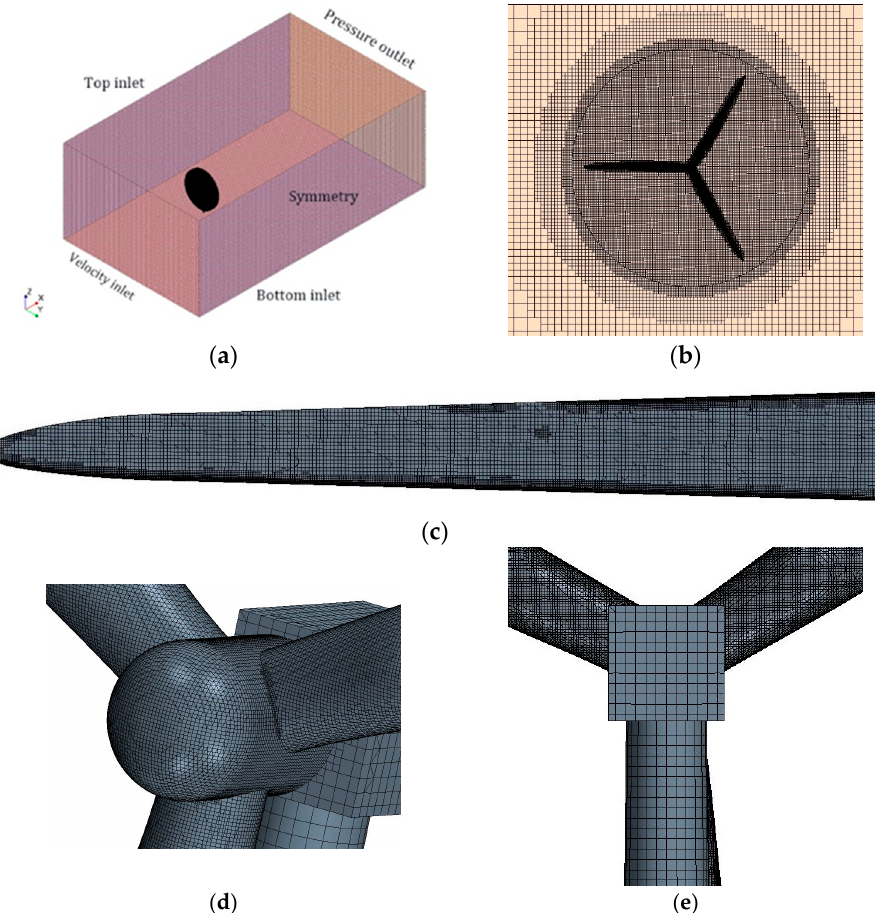
Figure 2. The computational mesh domain for the wind turbine: ( a ) full grid domain, ( b ) sliding mesh regions, ( c ) close-up view of the blade surface, ( d ) close-up view of the hub surface mesh and ( e ) close-up view of nacelle and tower.